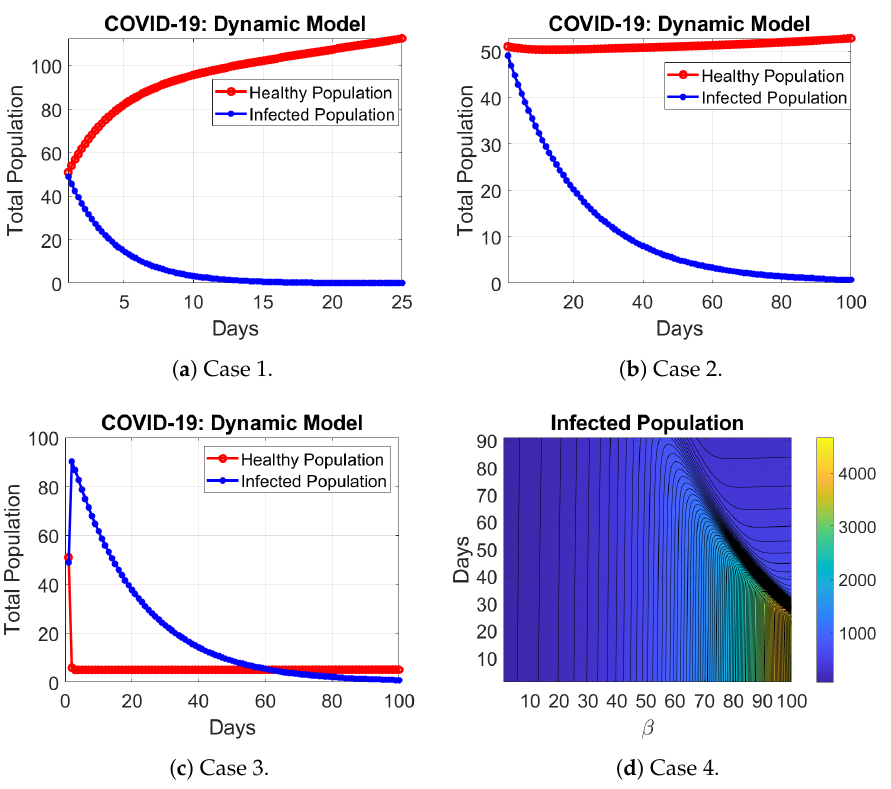
Figure 13. Experimental results based on the assumed 100 subjects evaluated for this